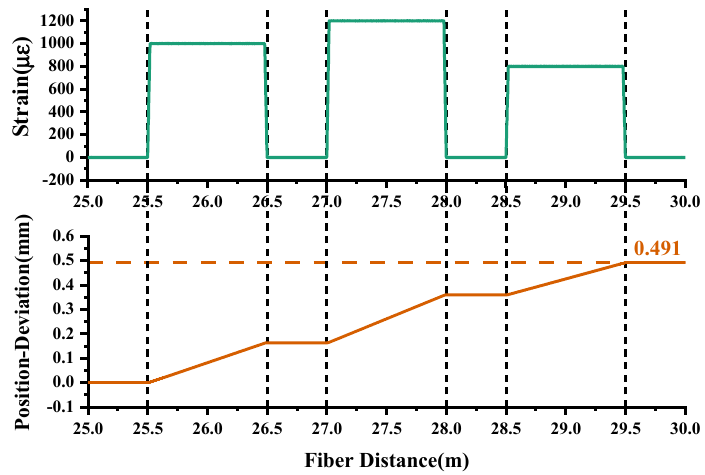
Figure 3. Accumulation of position deviation along sensing fiber after axial strain loaded.